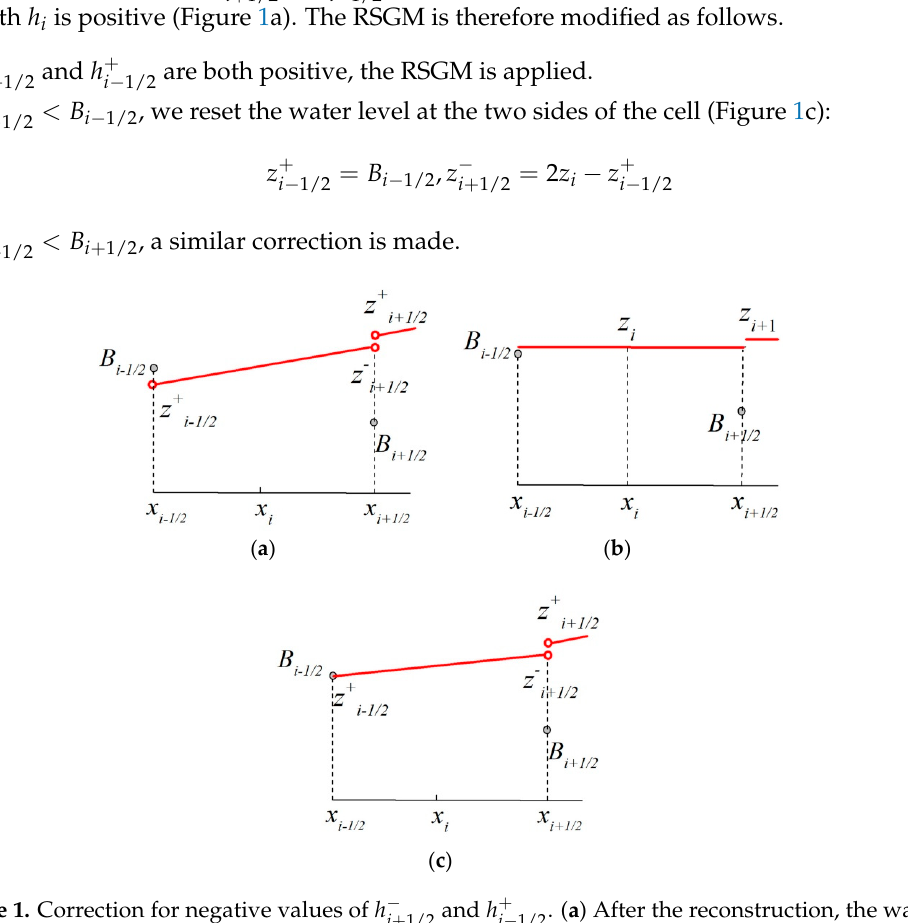
Figure 1. Correction for negative values of h − depth h + is negative at the right side of the i − 1/2 interface; ( b ) the average water depth h i i − 1/2 is positive; ( c ) the correction result. We reset z + corrected considering the conservation of the total amount of